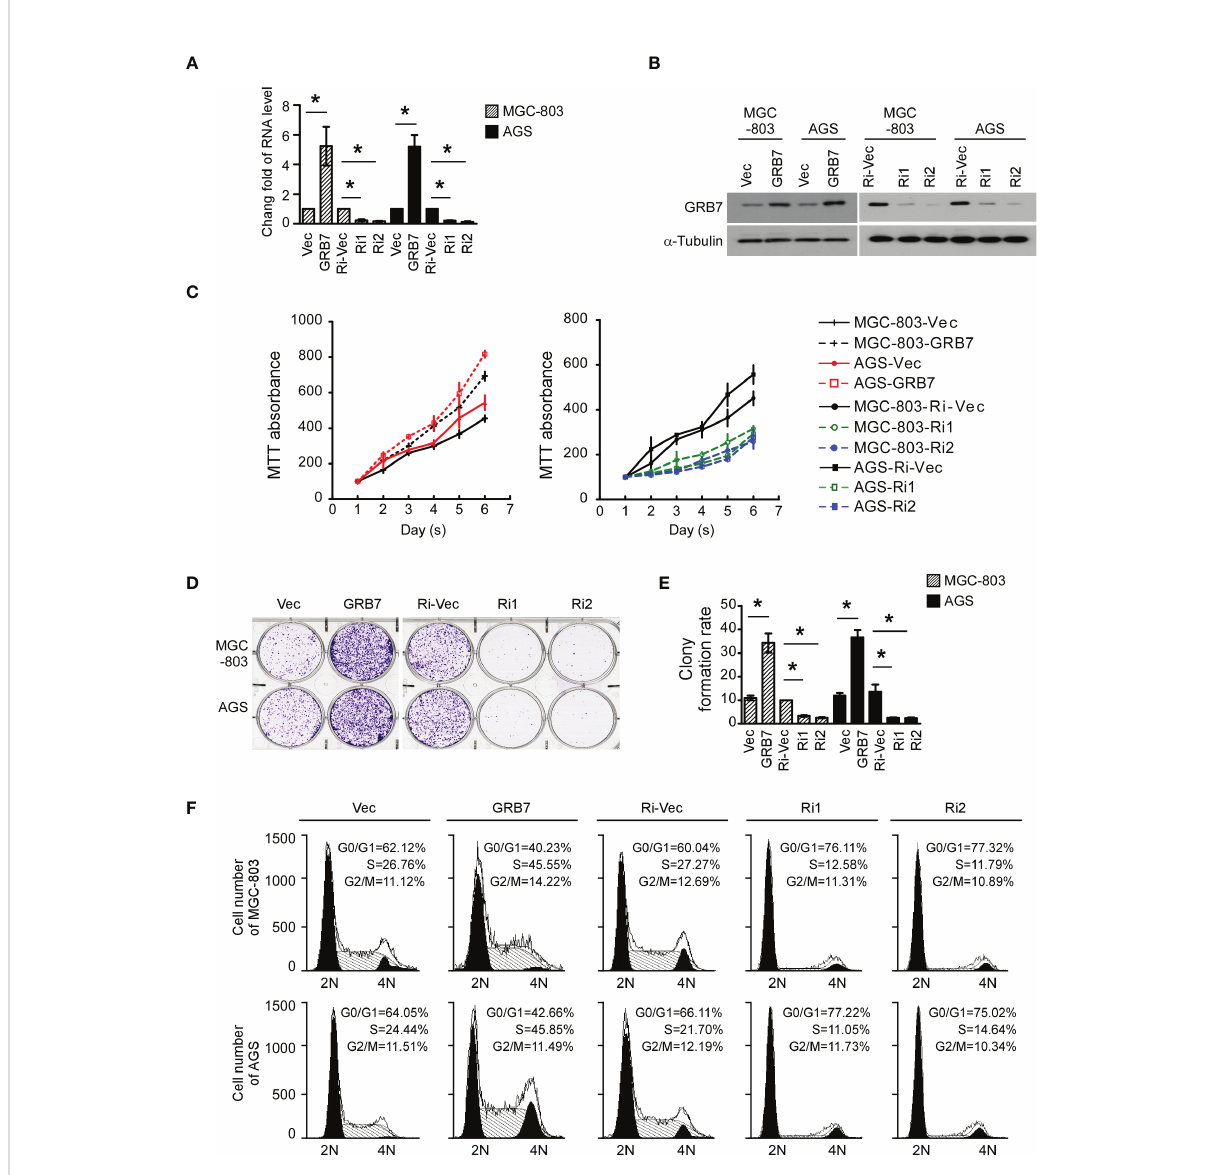
FIGURE 4 GRB7 promotes proliferation of gastric cancer cells. (A) Real-time quantitative PCR analysis showed that gastric cancer cell lines with high/low expression of GRB7 were successfully established. *P<0.05. (B) Western blot analysis showed that gastric cancer cell lines with high/low expression of GRB7 were successfully established. (C) MTT analysis showed that over-expression of GRB7 signi fi cantly accelerated cell proliferation, while low expression of GRB7 slowed down cell proliferation. (D, E) The representative pictures and statistical graphs of the colony formation test intuitively show that the expression of GRB7 is positively correlated with the number of colonies (mean ± standard deviation). *P<0.05. (F) Flow cytometry analysis described that GRB7 expression is positively correlated with the transition ability of cells in G1-S phase.